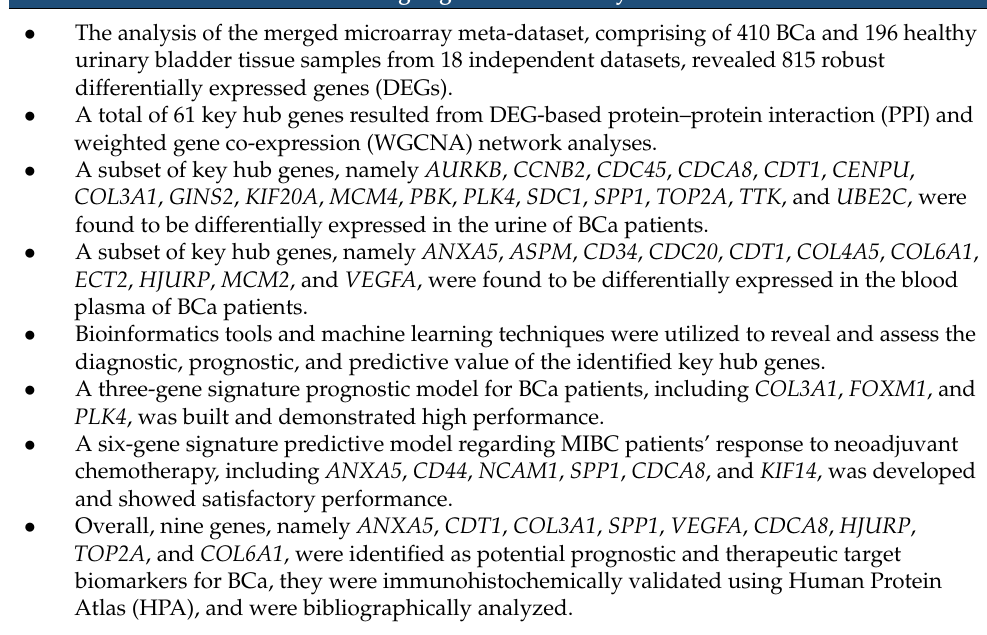
Figure S3: Volcano plot of DEGs between BCa and control samples in the merged meta-dataset. The DEGs were identified based on the criteria |log 2 (FC)| ≥ 1.3 and adj. p -value <0.01, as